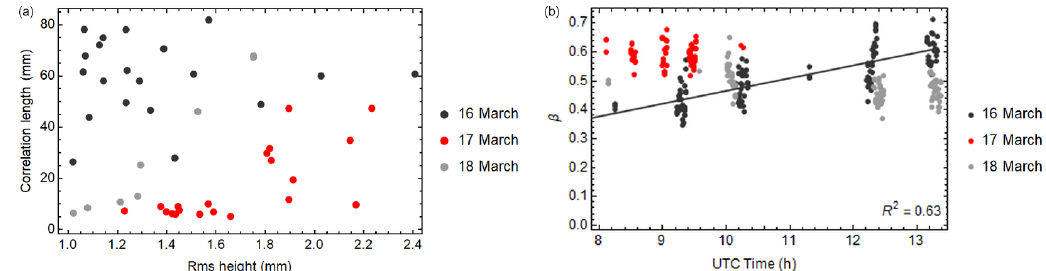
Figure 20. (a) The snow surface rms height and correlation length measured with the plate method during 16–18 March 2009. The values correspond to the distance 0.6m. (b) The rms slope angle β (in radians) of individual plate snow profiles during 16–18 March 2009. The linear regression for β vs. time is shown for 16 March, with the R 2 value